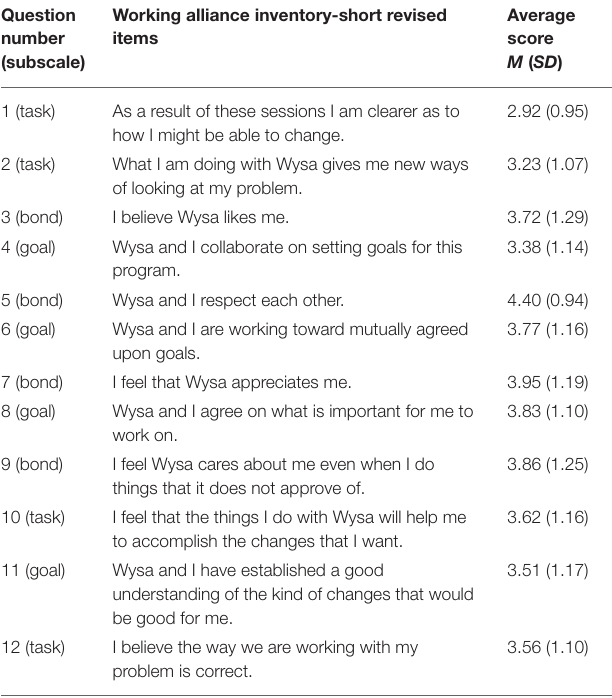
TABLE 1 | Adapted items of WAI-SR and Item-level descriptive statistics for Assessment 1 ( N = 1,205). Question